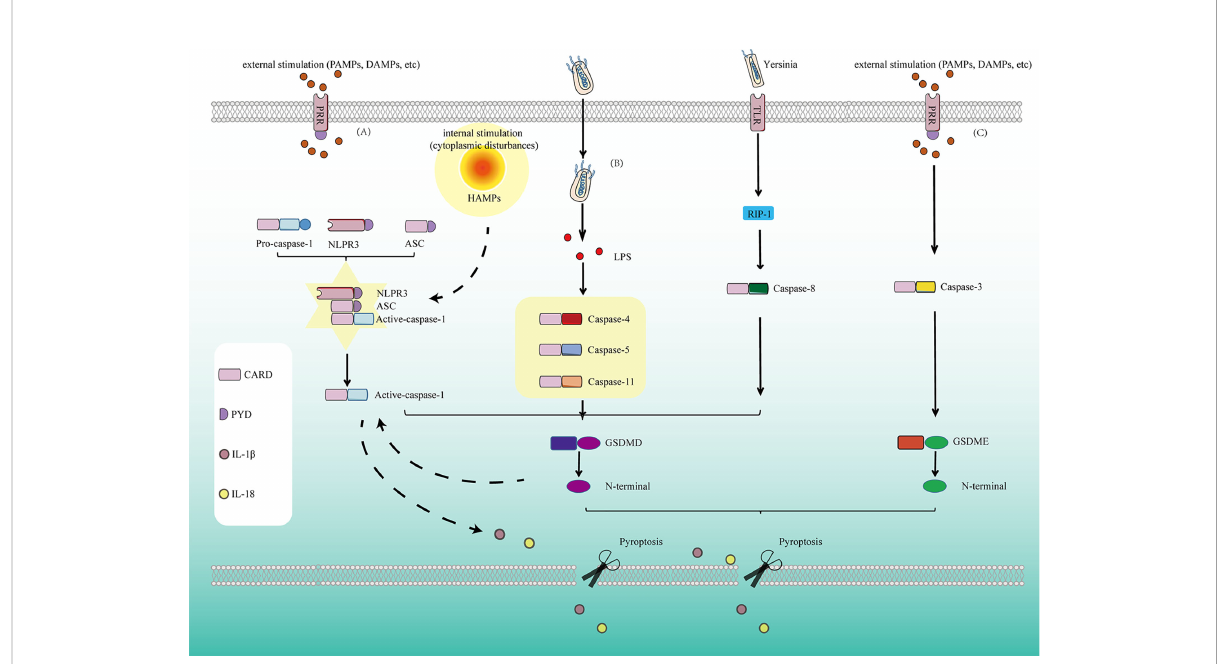
FIGURE 1 Pyroptosis is mediated by several pathways: (A) In the classical pyroptosis signaling pathway, NLRP3 is activated under the stimulation of PAMPs/ DAMPs as well as cytoplasmic disturbances, termed as homeostasis altering molecular properties (HAMPs), then the PYD at the NLRP3 N- terminal binds to the ASC protein containing the PYD domain, and the CARD of ASC binds to the CARD of pro-caspase-1 to form a multi- protein complex and activate Caspase-1. Activated Caspase-1 cleaves GSDMD and divides GSDMD protein into lipophilic N-terminal domain and hydrophilic C-terminal domain, the N-terminal domain binds to the lipids on the cell membrane to form pores, causing the release of cell contents. On the other hand, the N-terminal produced by cleavage from GSDMD has another function for promoting the proteolytic activation of caspase-1, helps to form active IL-1 b and IL-18. At the same time, cells release IL-1 b and IL-18 released to the outside of the cell during pyroptosis recruit more in fl ammatory cells and expand the in fl ammatory response. (B) In the non-classicial pyroptosis signaling pathway, Caspase-4, 5, and 11 are activated under the stimulation of bacteria and other signals. The GSDMD is cleaved by the activated Caspase-4, 5, and 11 to form the lipophilic N-terminal domain, inducing cell membrane perforation and causing in fl ammation. (C) In Caspase-8-dependent pyroptosis signaling pathway, Caspase-8 is activated by Yersinia via the TLR4/RIP1 signaling pathway to induce pyroptosis. (D) In Caspase-3- dependent pyroptosis signaling pathway, Caspase-3 promotes the recruitment of the GSDME-N domain to the cell membrane by cutting off GSDME and induces the formation of cell pores, thus leading to